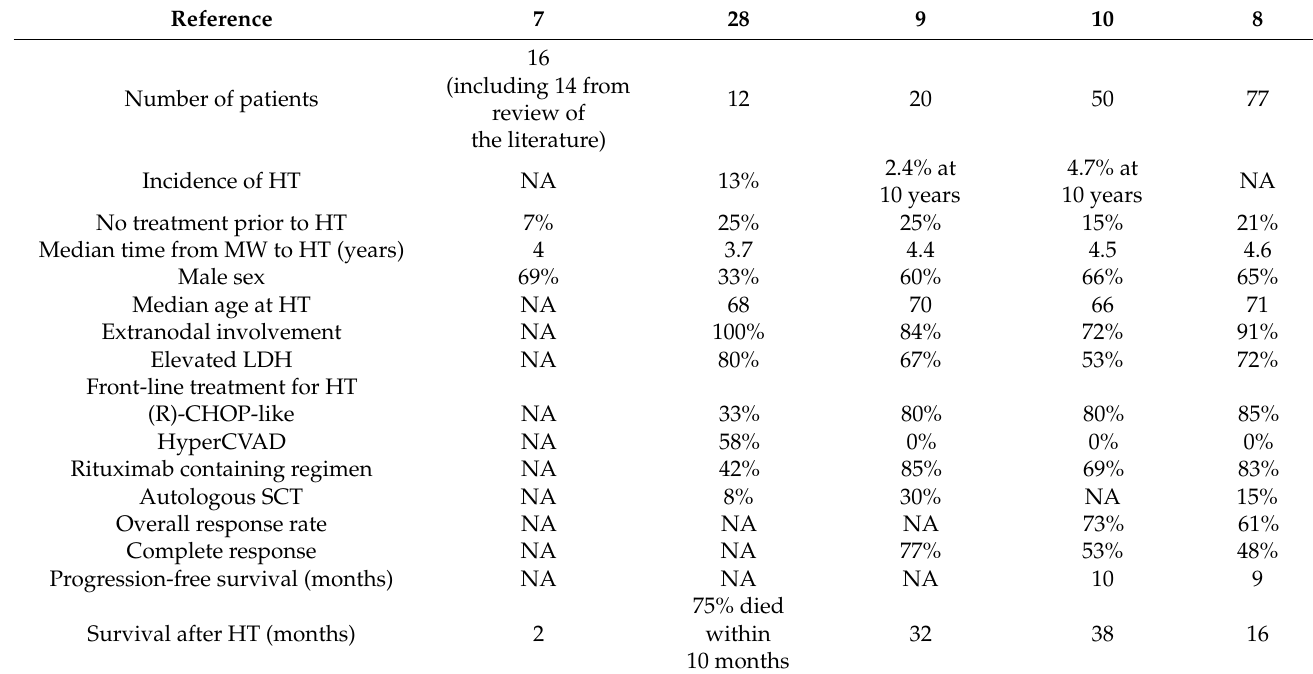
Table 1. Summary of the major published retrospective studies on HT in